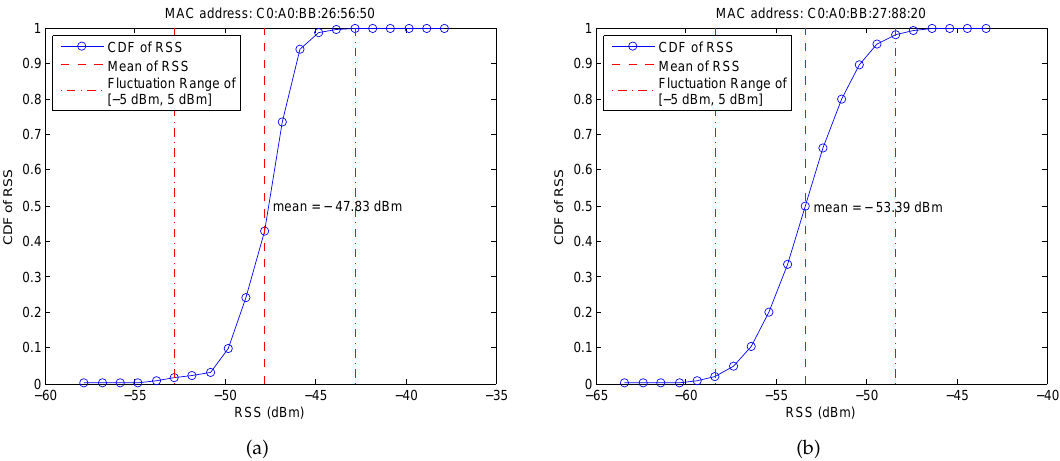
Figure 6. CDFs of RSS from two different APs for 3 min. ( a ) RSS from AP with the MAC address C0: